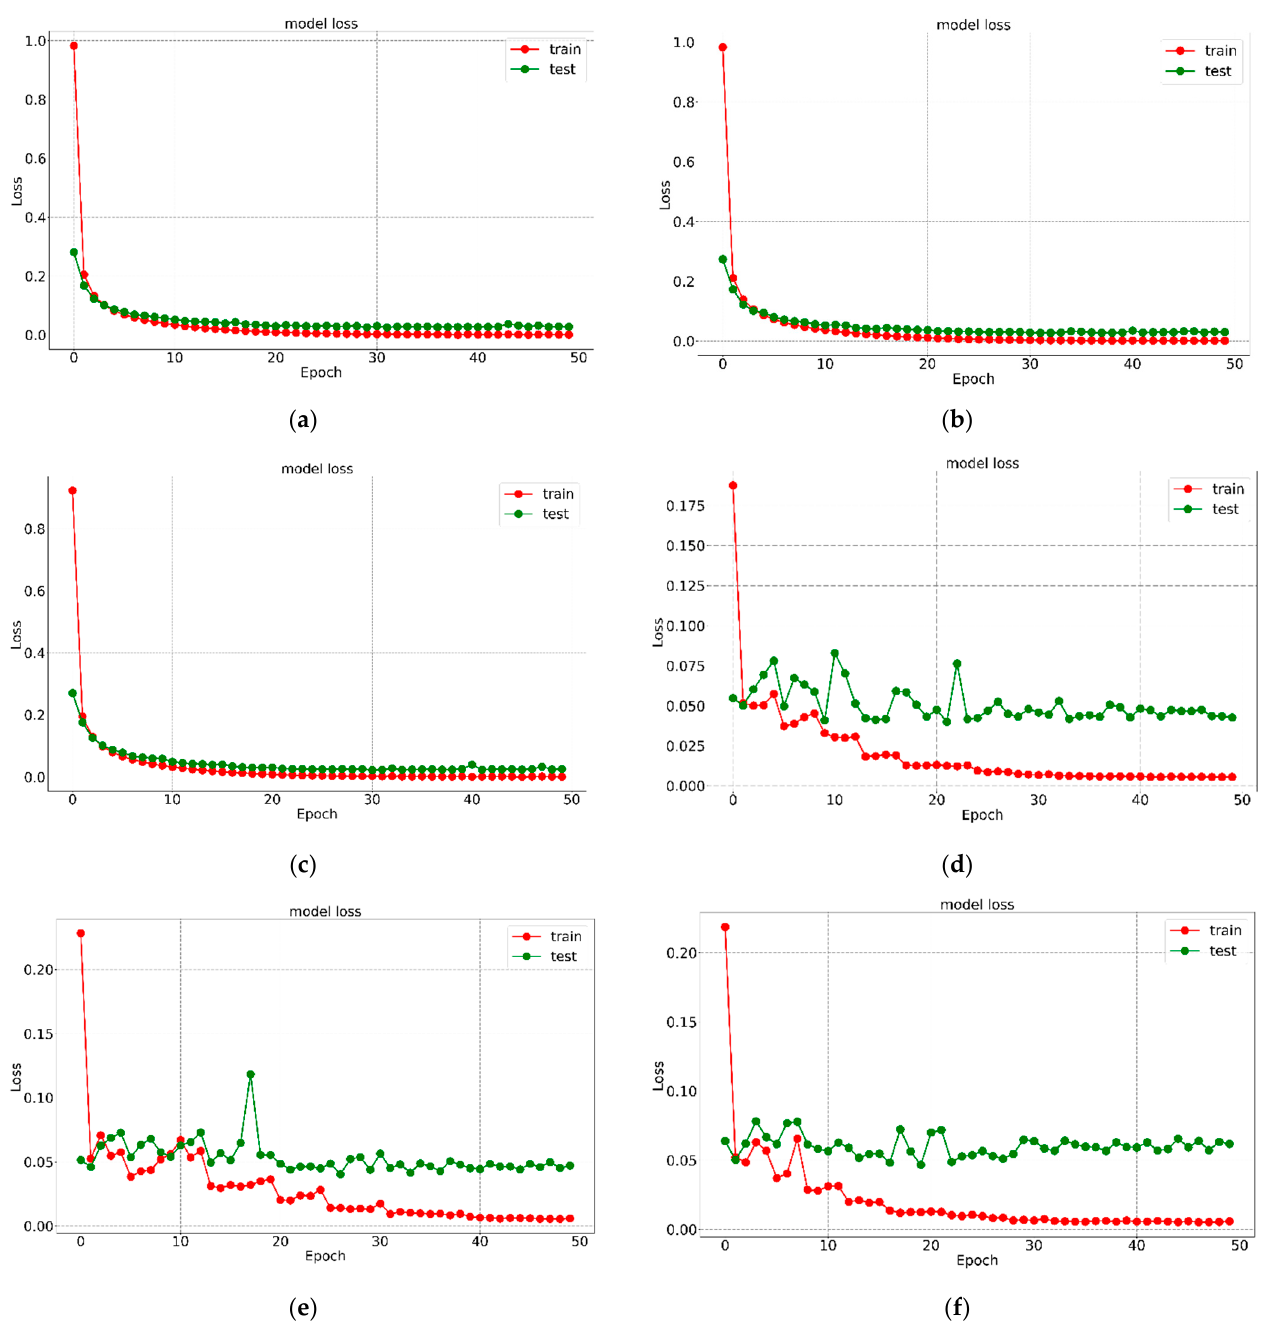
Figure 10. Validation loss of the six models for English alphabet recognition. ( a ) Optimizer—‘ADAM’; learning rate—0.001. ( b ) Optimizer—‘ADAM’; learning rate—0.0001. ( c ) Optimizer—‘ADAM’; learning rate—0.00001. ( d ) Optimizer—‘RMSprop’; learning rate—0.001. ( e ) Optimizer—‘RMSprop’; learning rate—0.0001. ( f ) Optimizer—‘RMSprop’; learning rate—0.00001.